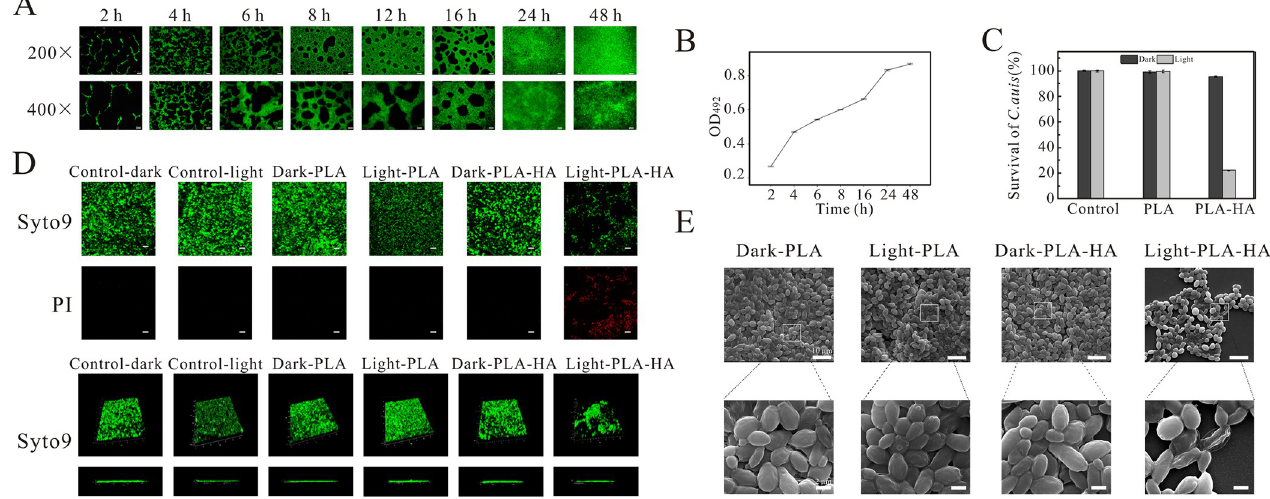
Fig 4. Biofilm formation and capacity of C . auris biofilm eradication. (A) Observed C . auris biofilm formation at different times using Styo9 staining. Scale = 200 μ m. (B) Growth curve of C . auris biofilm by the XTT reduction method. (C) Capacity of C . auris biofilm eradication of PLA and PLA-HA with and without illumination using the XTT reduction method. (D) Live/Dead staining of C . auris biofilms observed by CLSM. Scale = 10 μ m. E. SEM images of C . auris biofilm with PLA and PLA-HA treatment. Data are presented as the mean ± s.d. n = 3.